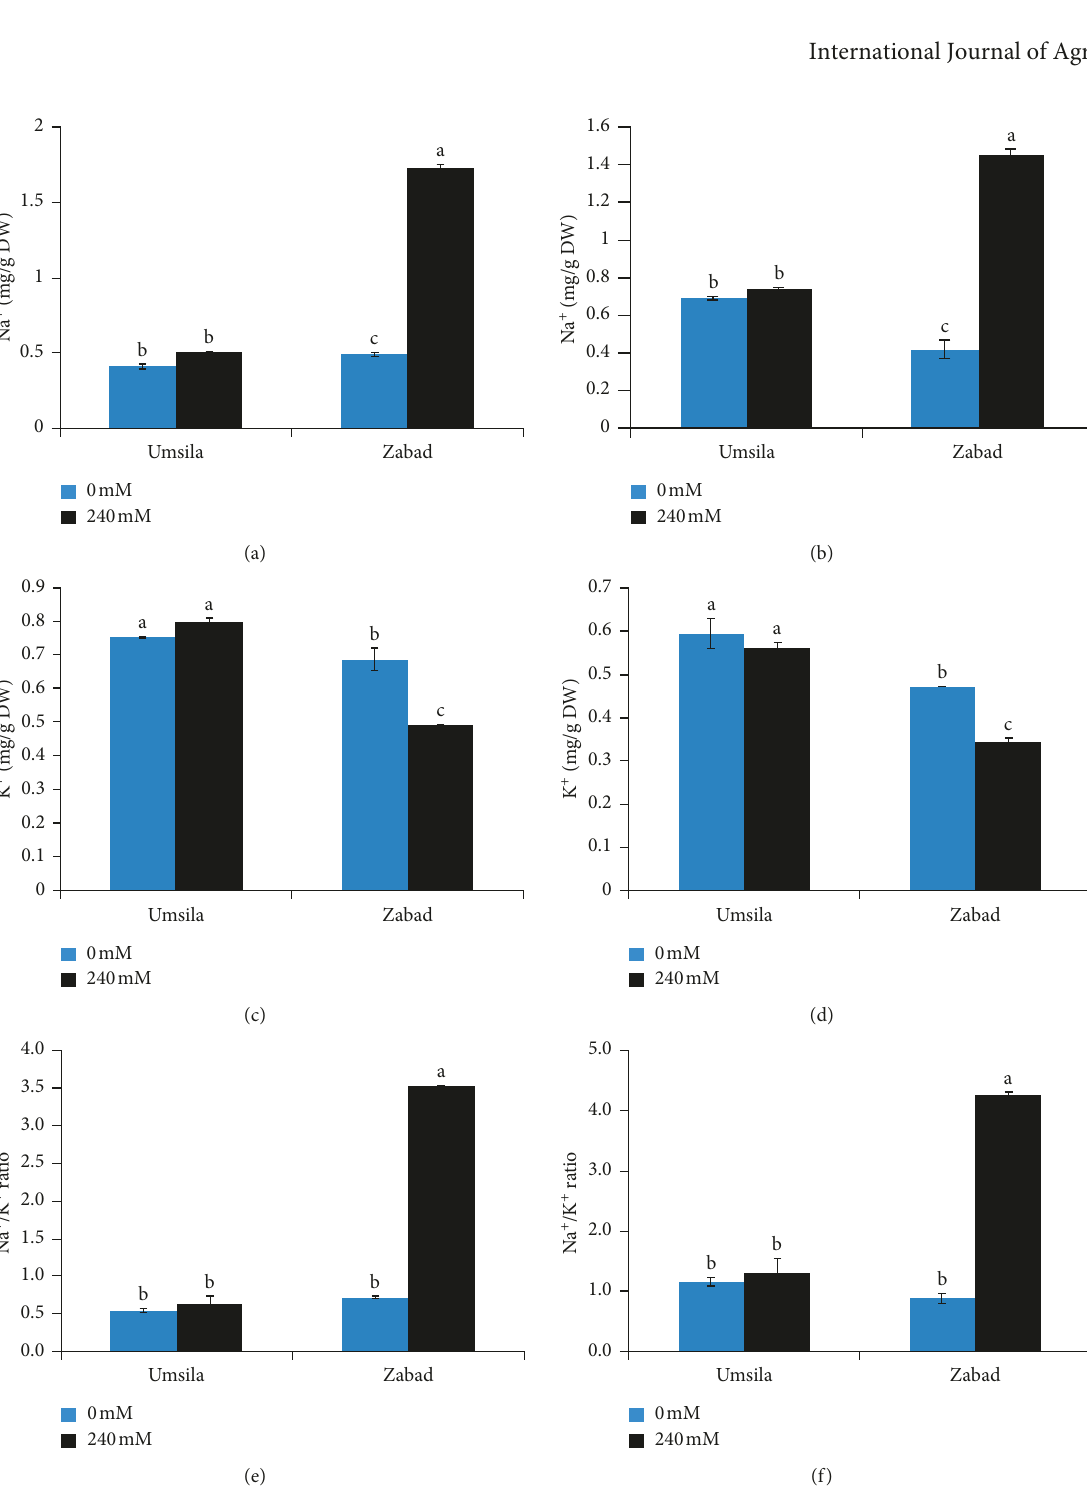
Figure 5: The effect of salinity on the accumulation of sodium (Na + ) in leaves (a) and roots (b), the accumulation of potassium (K + ) in leaves (c) and roots (d), and the Na + /K + ratio in leaves (e) and roots (f) of date palm seedlings when exposed to control (0mM NaCl) and salinity (240 mM NaCl) conditions. Bars represent the mean ± SE ( n � 3). Bars with the same letter are not significant at p ≤ 0 .